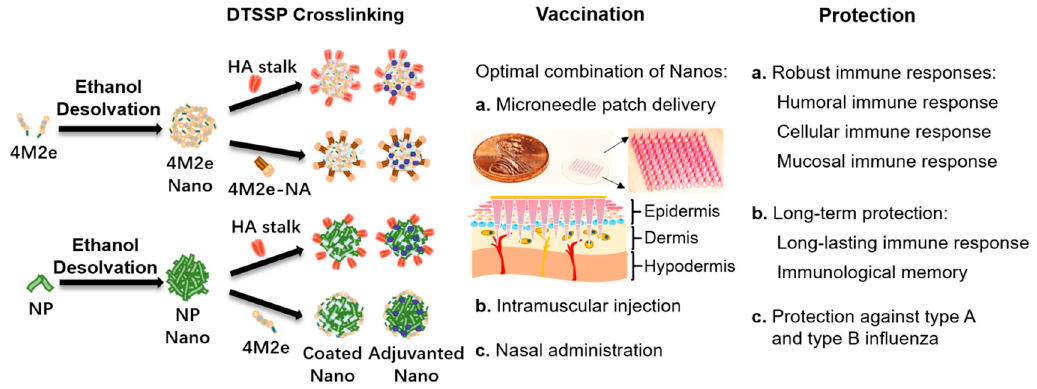
Figure2. Diagramofnanoparticlecreationfromconservedimmunogens,vaccinationroutes,andprotection. At left: A diagram illustrating the formation of layered protein nanoparticles through ethanol desolvation of immunogens into core particles followed by DTSSP crosslinking of an outer layer of immunogens onto the core. At center: A list of possible vaccination routes with protein nanoparticles. At right: A list of protective immune response goals for a universal influenza